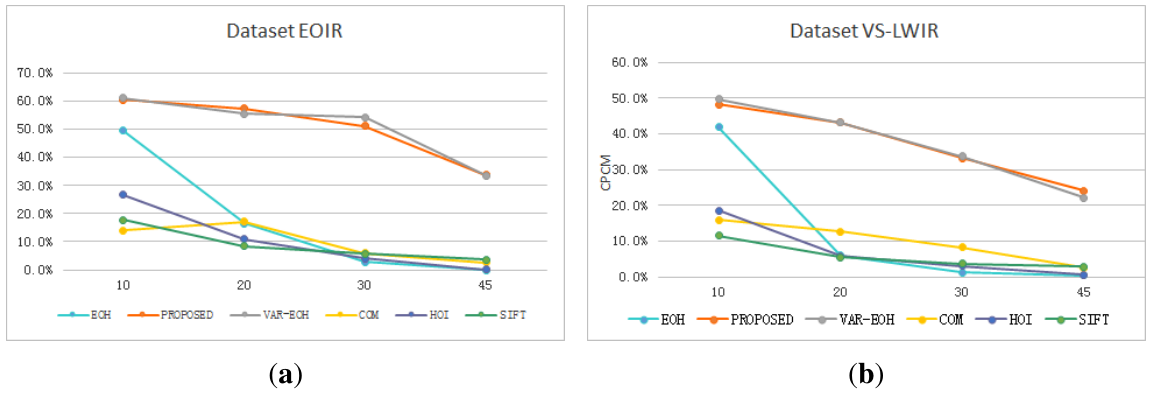
Figure 6. Comparison of keypoint matches for different methods. The horizontal axis represents the degree of rotation, and the vertical axis represents the percent of correct matches. Correct matches are defined to be of a distance falling in (0 10]. ( a ) The result on dataset EOIR; ( b ) the result on dataset VS-long-wave infrared (LWIR). On both EOIR and VS-LWIR, the performance of every method decreases when the rotation degree increases. The proposed method and the variant EOH with main orientation decrease significantly slower than the original EOH, SIFT main orientation, COM and HOI on both datasets, varying the effectiveness of the main